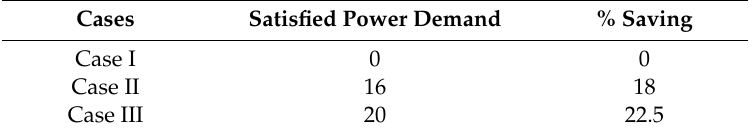
Table 9. Comparison of the proposed and existing satisfied power demands within case-I, II and III.